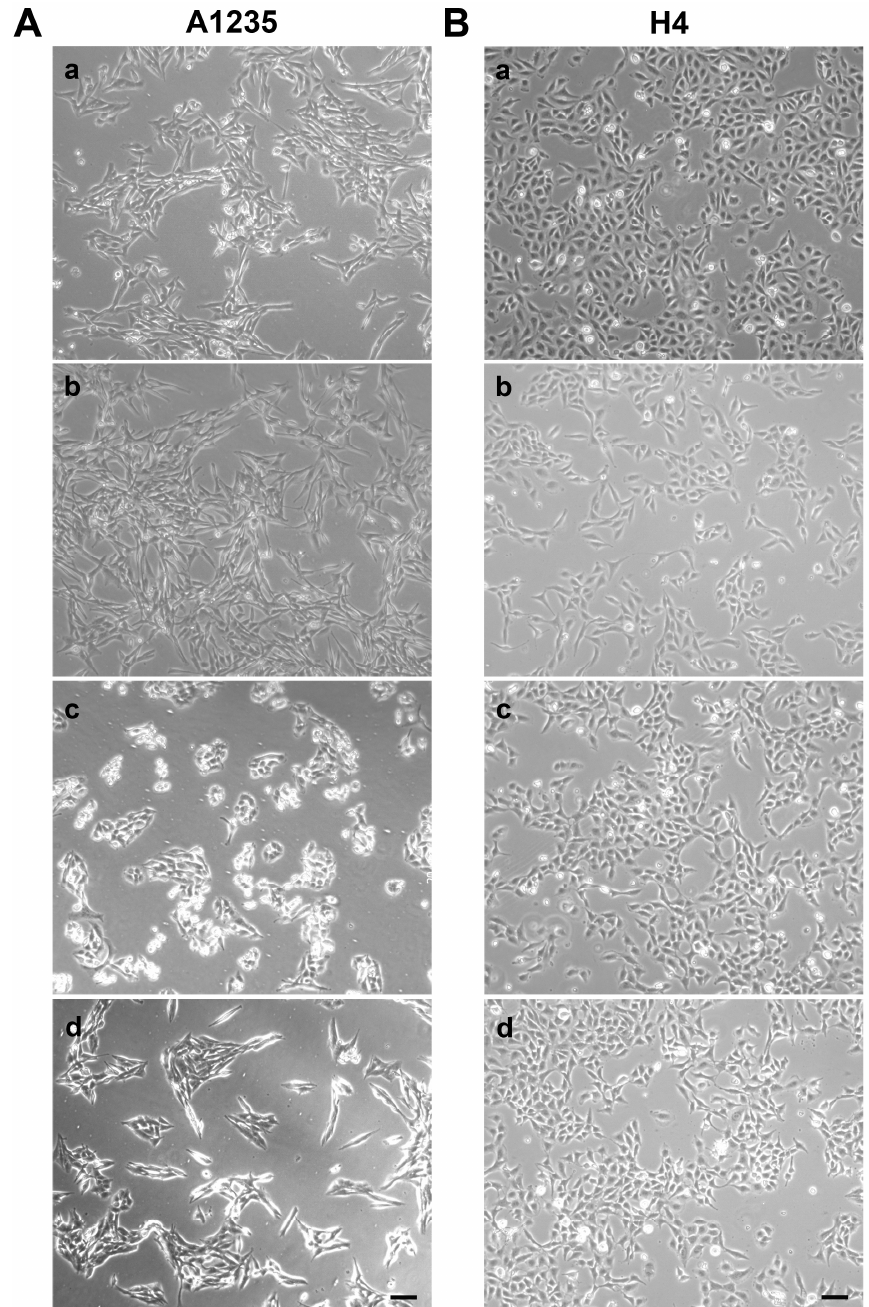
Figure 2. Morphology of A1235 glioblastoma and H4 neuroglioblastoma cells after 9 days of treatment with ATRA and the PARP inhibitor: Microphotographs were taken with epifluorescent microscope Axiovert 40 CFL. ( A ) A1235 cells; ( B ) H4 cells; a : control; b : cells treated with 20 µ M PJ-34; c : cells treated with 10 µ M ATRA; and d : cells treated with 10 µ M ATRA and 20 µ M PJ-34. Pictures were taken at magnification of 100 × , scale bar = 100 µ